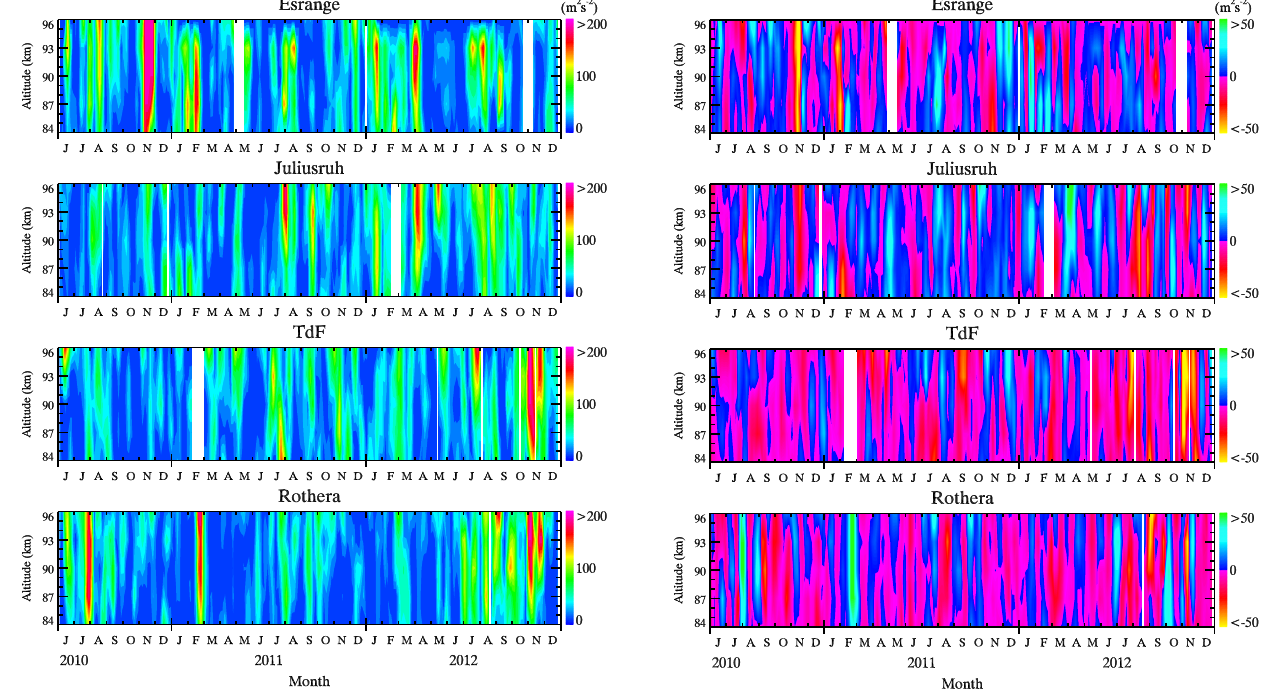
Figure 3. 5-day mean horizontal momentum fluxes of the 5DW as a function of altitude between 84 and 96km over Esrange, Juliusruh, Tierra del Fuego, and Rothera from top to